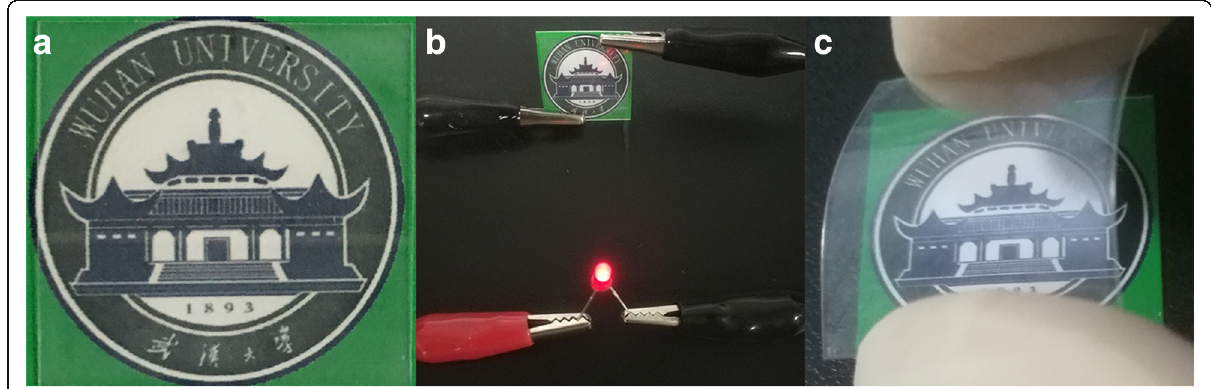
Fig. 7 a Optical image of as-fabricated Ag NWs films on PET. b Ag NWs film is connected in an electric circuit in which an LED is lit. c Optical image of the flexible Ag NWs film